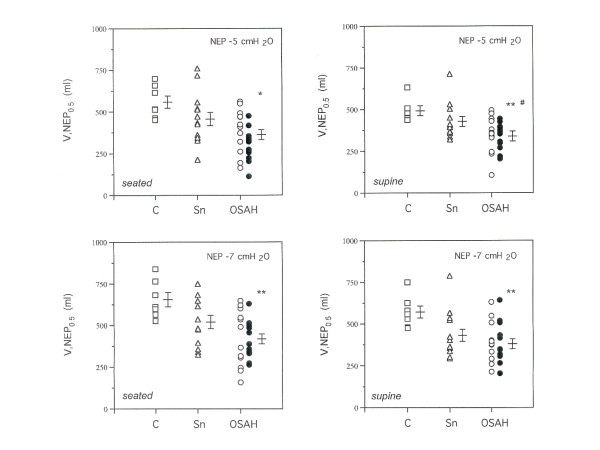
Individual values of V,NEP 0.5 in seated and supine position at two NEP  levels in patients with obstructive sleep apnea-hypopnea (OSAH) (circles,  white for mild-to-moderate OSAH and black for severe OSAH), snorers (Sn)  (triangles) and controls (C) (squares).  *p<0.01 vs C; **p<0.001 vs C; #p<0.05 vs Sn.